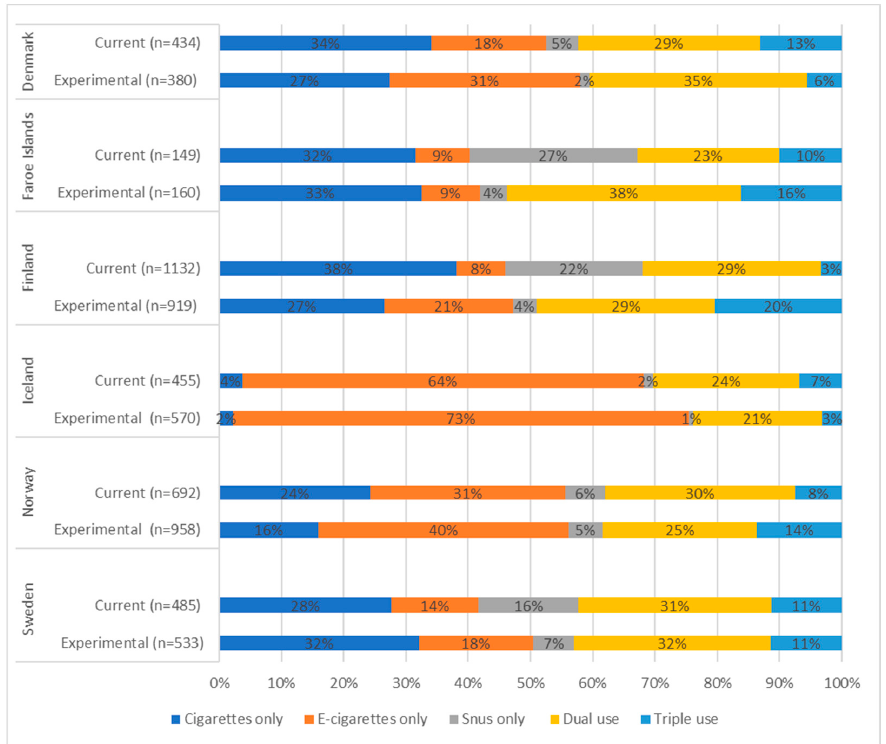
Figure 2. Percentages of lifetime single, dual, and triple use of cigarette, e-cigarette, and snus among current and experimental users, by country.